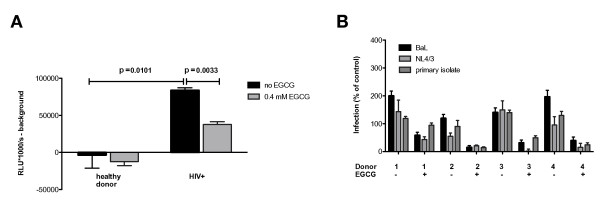
EGCG effectively inhibits semen-enhanced viral infection of autologous virus/semen and R5- as well as X4-tropic viruses. A) Semen samples from a healthy donor and an HIV-1-positive patient with high viremia were preincubated in presence or absence of 0.4 mM EGCG and subjected to the infection assay as described in the methods section. Semen was used undiluted during preincubation. Columns represent luciferase activity minus background (luciferase activity in control experiments performed without semen) expressed as RLU/s*1000. Error bars represent the standard error of the means. The indicated p-values result from unpaired, two-tailed Student's t-test analysis. Significantly higher luciferase activity in cells incubated with semen from the HIV-patient than in cells incubated with semen from the healthy donor demonstrates successful infection. B) To analyze semen-mediated enhancement of HIV-1 infectivity and its inhibition by EGCG with regards to different virus strains, three different HIV-1 strains were deployed: BaL (R5-tropic), NL4/3 (X4-tropic) and a primary HIV-1B isolate. Four individual semen samples were subjected to the infection assay described above in presence or absence of 0.4 mM EGCG.